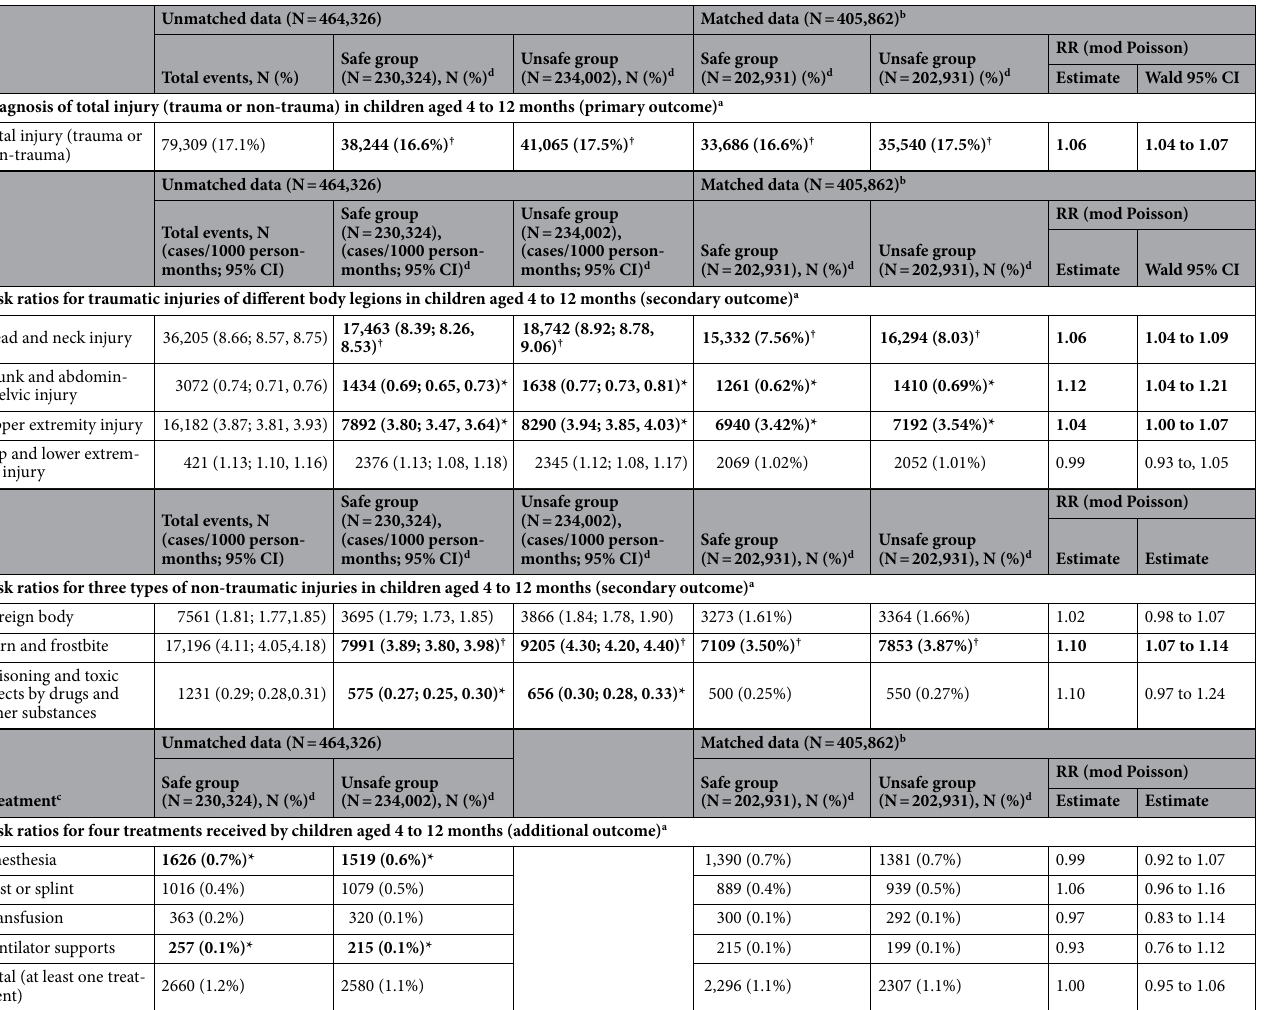
Table 2. Risk ratios for injuries and treatments in children aged 4 to 12 months. N number, RR relative risk, CI confidence interval. a Unless otherwise specified, all treatments were assessed at the age of 4 to 12 months. b Matched using inverse probability of exposure matching, based on propensity scores. The propensity score was estimated using multivariable logistic regression with covariates chosen a priori (Table S2). c Treatments were based on NHIS codes (Supplementary Appendix 1). d Values are reported as N (%) unless otherwise indicated. * p < 0.05, † p < 0.001. Significant values are in